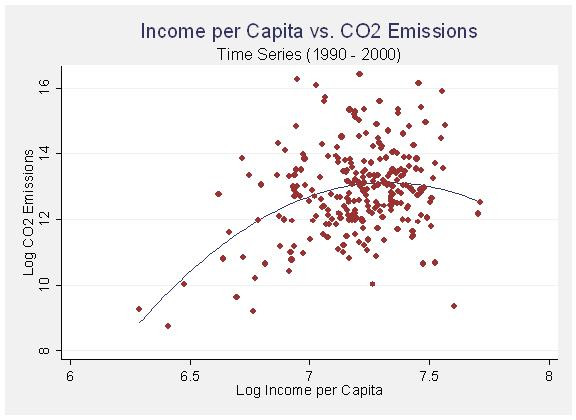
Income per Capita vs. CO2 Emissions (Panel 1990 – 2000).